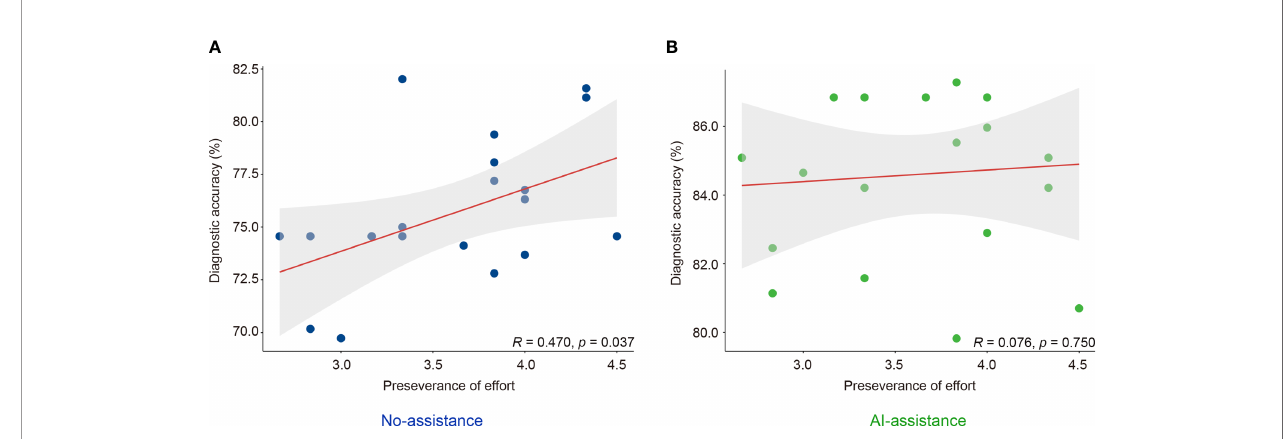
FIGURE 3 | Correlation of perseverance of effort and diagnostic accuracy of endoscopists with (B) or without (A) the DCNN model ’ s